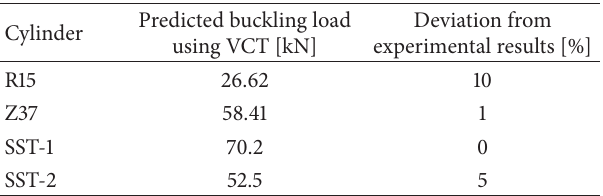
Table 6: Variation of the 2nd vibration frequency with the applied load on the SST-2 cylinder.